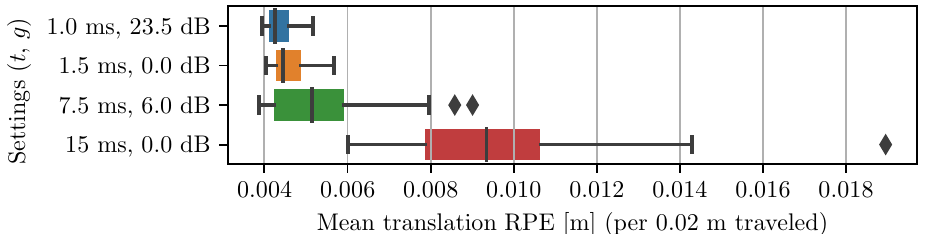
Figure 7. VO performance acquired with the three-axis motion table for different fixed exposure parameters. Each pair of parameters (exposure time, gain) is used over four recordings. Each recording is post-processed 10 times with ORB-SLAM. Failed runs (tracking lost) are not included.